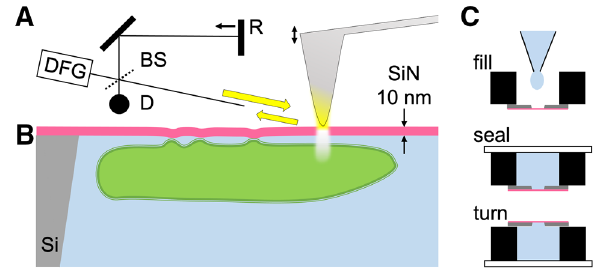
Figure 1. SiN-membrane-based infrared probing into liquids, ( a ) nano-FTIR spectroscopic near-field microscopy layout using light focused on a metallic AFM tip to induce an intense near-field spot which is as narrow as the tip and extends a similar distance below the tip apex (white patch) 8,44 . A sample scanned below the tip, through the near-field spot, modifies the back-scattered light which is detected at the detector (D), via a Michelson interferometer that employs a beam splitter (BS) and a movable reference mirror (R) to form highly resolved infrared s-SNOM images. When the light is broad-banded, e.g., from a DFG (difference-frequency generation) source, a nano-FTIR spectrum can be measured at any sample position, in both scattered amplitude and phase. In addition, the tapping tip (double arrow) may sense membrane surface deformations via the AFM circuitry. ( b , c ) Liquid-sample cell consisting of a small metal container (black) carrying a perforated Si chip (grey) that is closed by a 10-nm thin SiN membrane (pink), loaded by drop-casting a suspension and waiting for particles or cells to settle and adhere to the membrane (top), then sealed (mid) and finally turned upside down (bottom) for microscopy so that the probing tip touches the upper surface of the membrane. When particles or cells adhere to its lower surface, the membrane can become locally distorted, as illustrated, and thus can enable a mapping of the field of adhesion